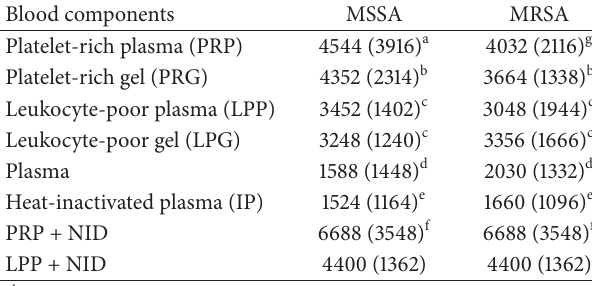
Table 5: TGF- 𝛽 (pg/mL) concentration in every blood component 1 cultured with either MSSA or MRSA at 24 hours.